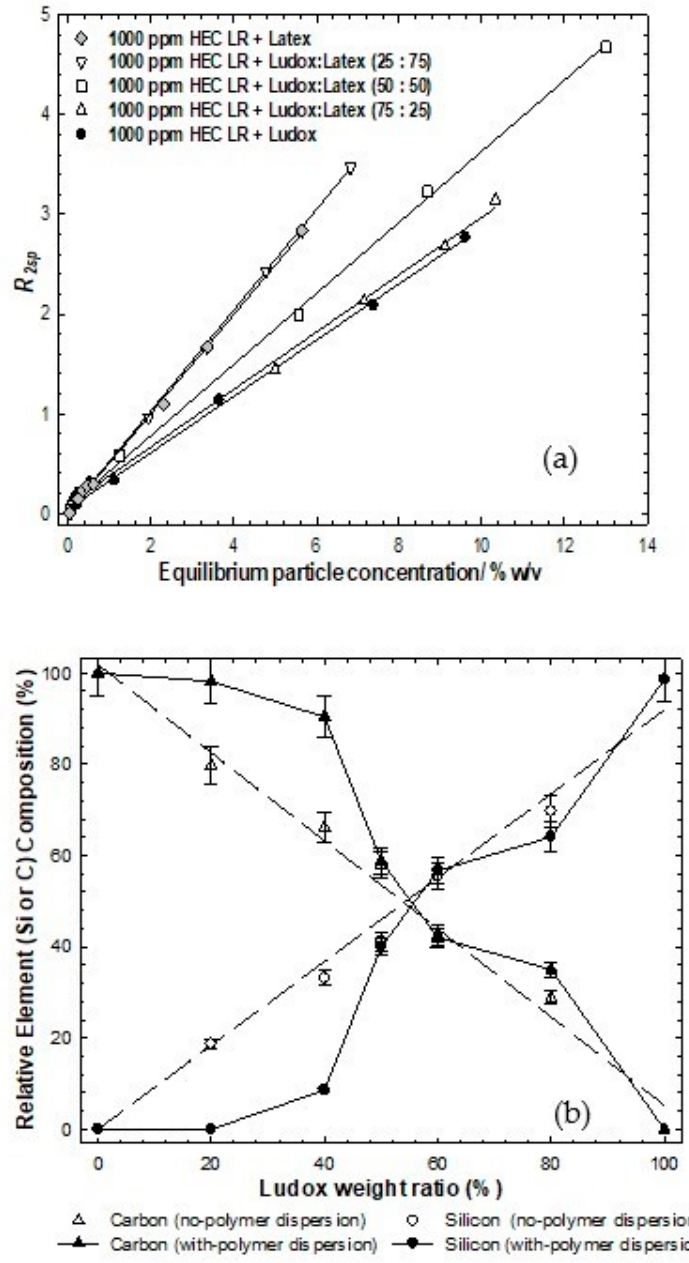
Figure 4. ( a ): Solvent-specific relaxation rates as a function of the equilibrium particle concentration for binary particle mixtures of Ludox post-centrifugation and exposure to 1000 ppm HEC LR. The lines are simple linear regressions to aid the eye; ( b ): EDAX data for a series of binary Ludox/latex particle mixtures with initial particle weight fraction of 10 wt% post-centrifugation and exposure to 1000 ppm HEC LR.